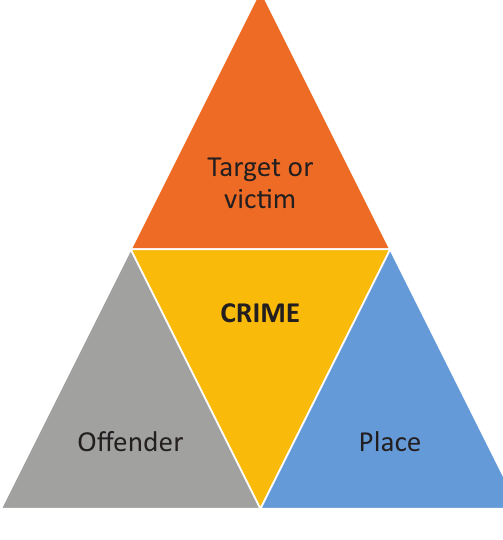
Figure 2. The Problem Analysis